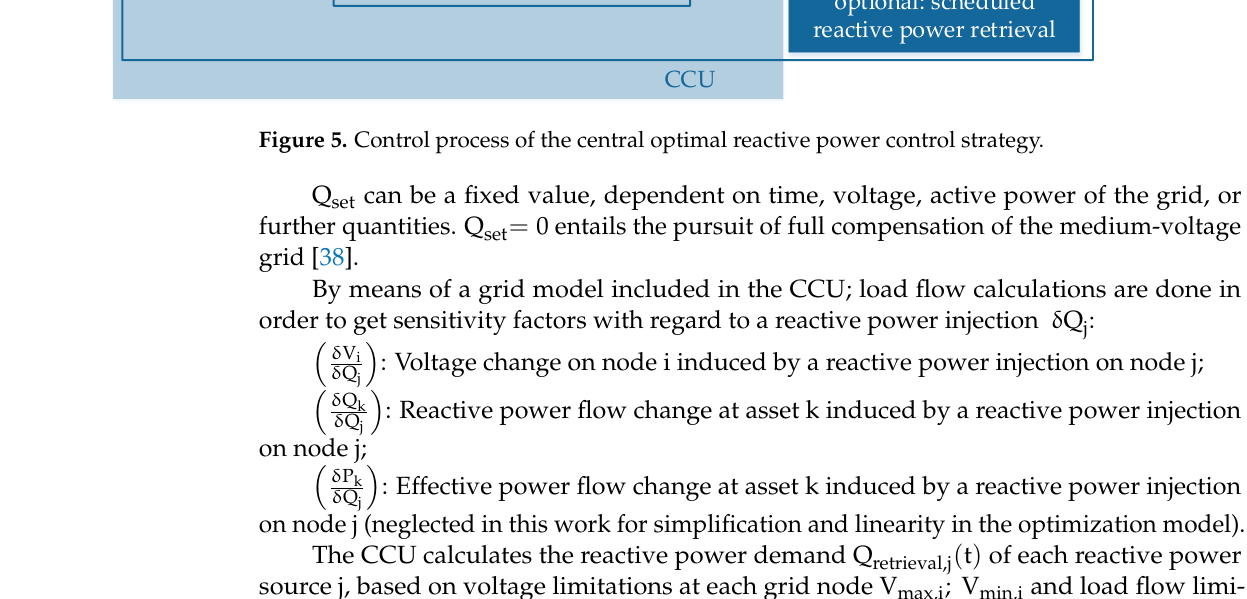
Figure 6. Schematic illustration of the central reactive power control strategy in an exemplary me- dium-voltage grid with an industrial company with two ICS as reactive power sources.